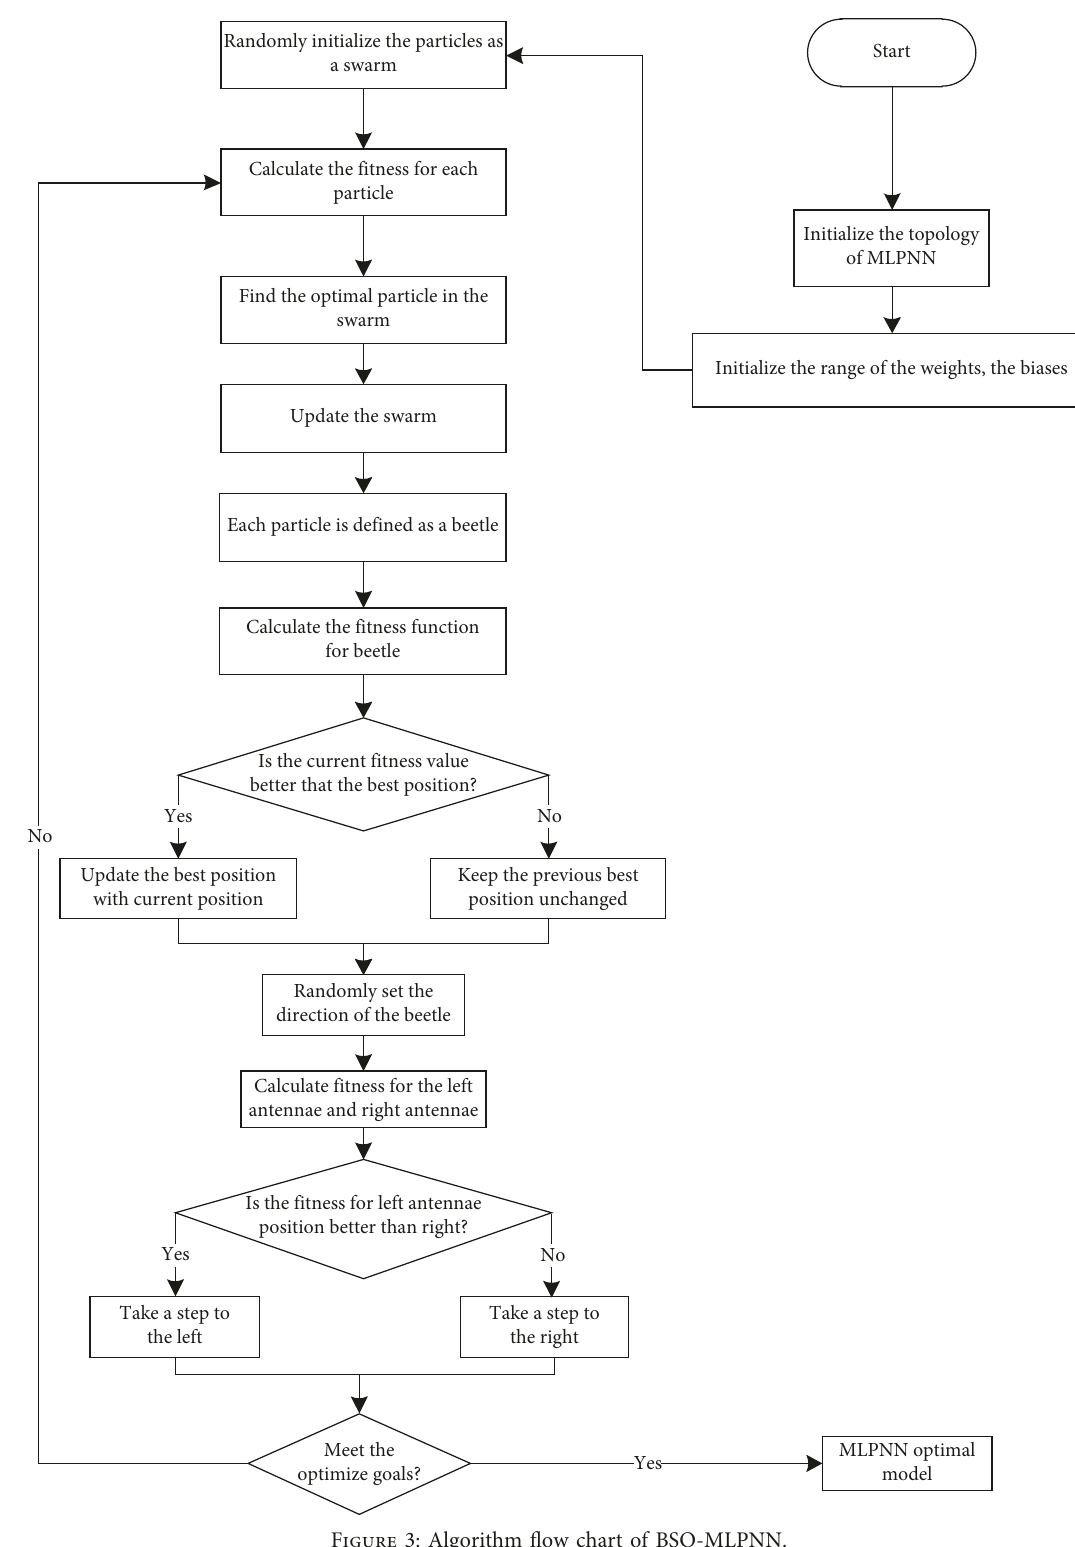
Figure 3: Algorithm flow chart of